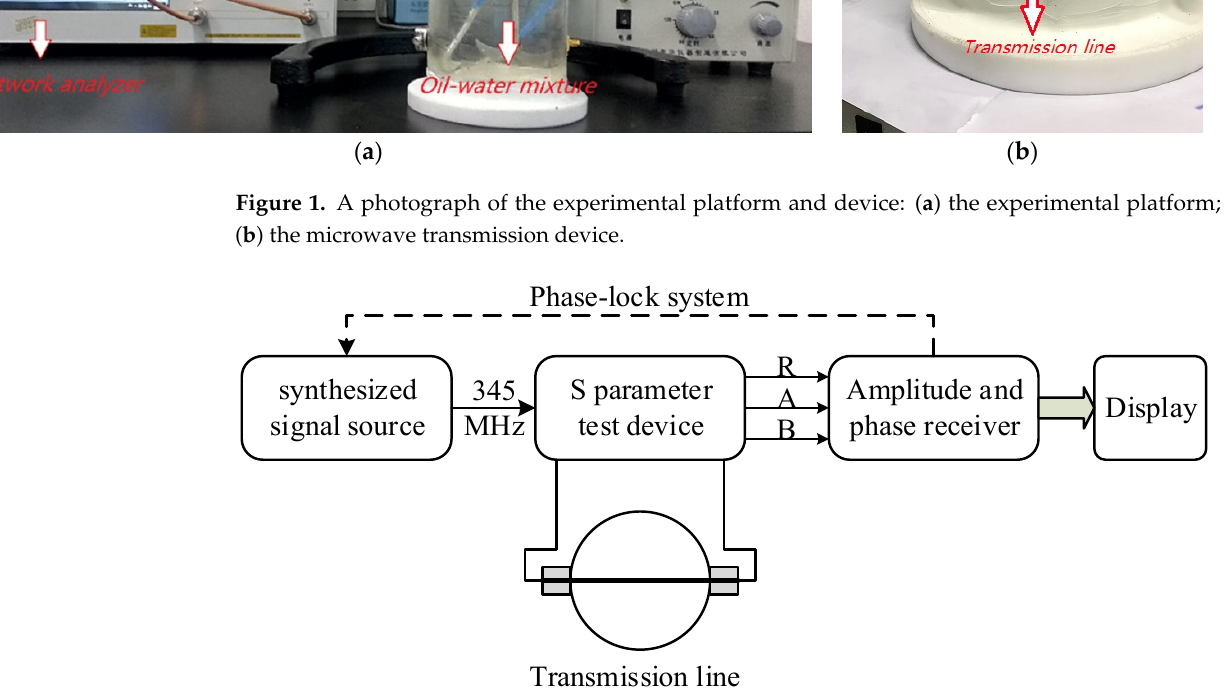
Figure 2. The schematic diagram of the microwave sensor.